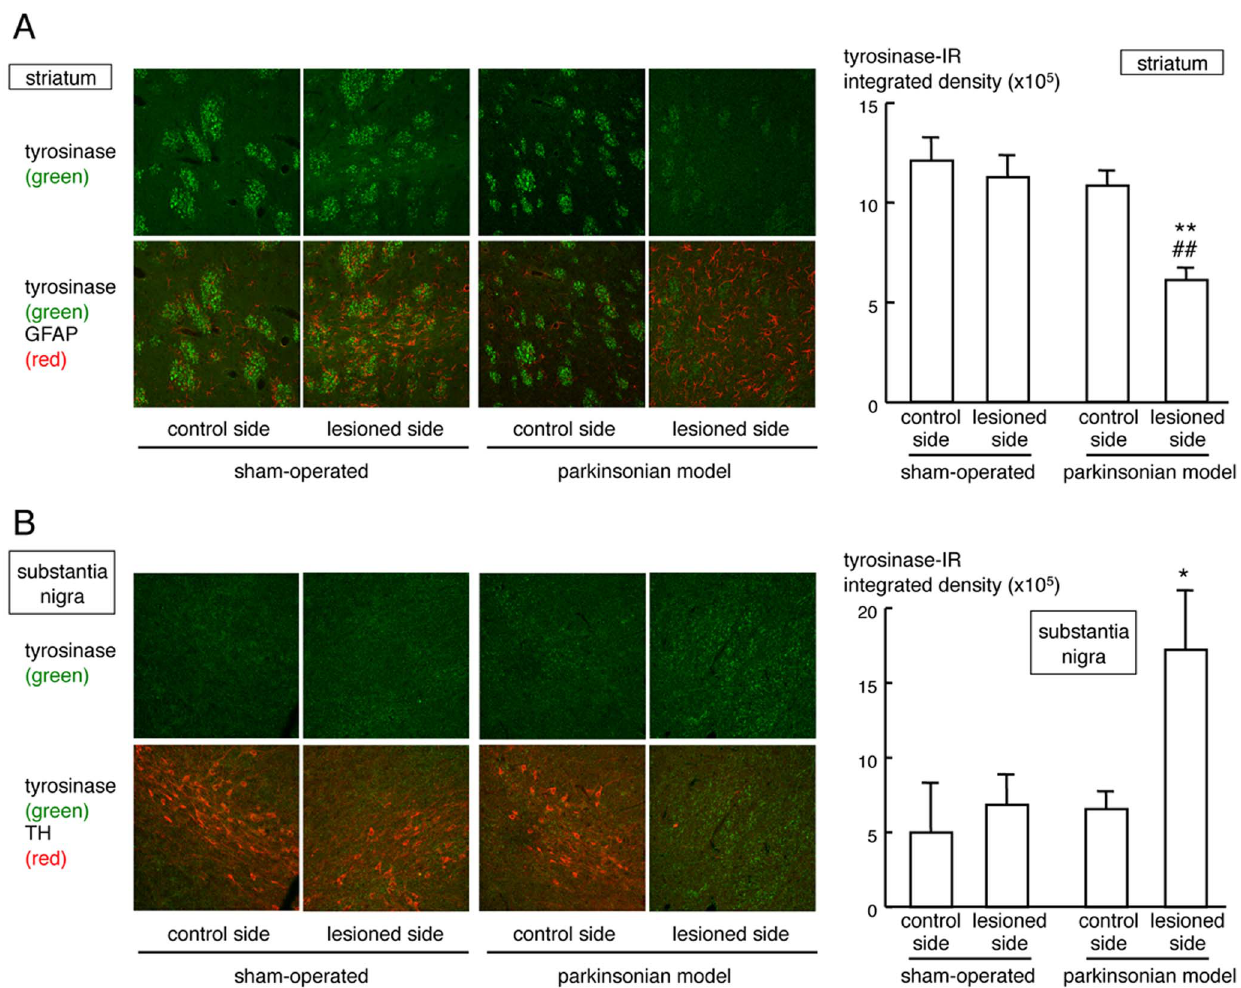
Figure 1. Expression of tyrosinase in the basal ganglia of hemi-parkinsonian rats. (A) Immunofluorescence signals using anti-tyrosinase antibody (green) and anti-GFAP antibody (red) in the mid-striatum on the control side or lesioned side of hemi-parkinsonian rats and sham-operated controls at 4 weeks after lesioning by 6-OHDA injection. (B) Double immunofluorescence staining using anti-tyrosinase antibody (green) and anti-TH antibody (red) in the substantia nigra of the intact side or lesioned side of hemi-parkinsonian rats and sham-operated controls. (A, B) Each right panel shows means integrated density of tyrosinase-IR 6 SEM (n=3). * p , 0.05, ** p , 0.01 vs. intact side of each treated group. ## p , 0.01 vs. side-matched sham-operated control